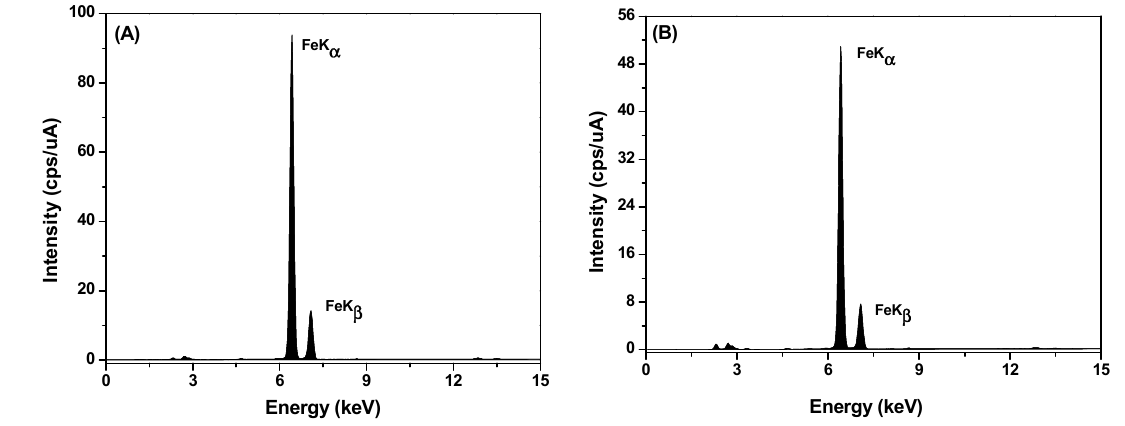
Figure 5. Energy dispersive X-ray spectra of the nanoparticles. ( A ) PMMA / OM-OA; ( B ) PMMA / OM-OA / PVPi.